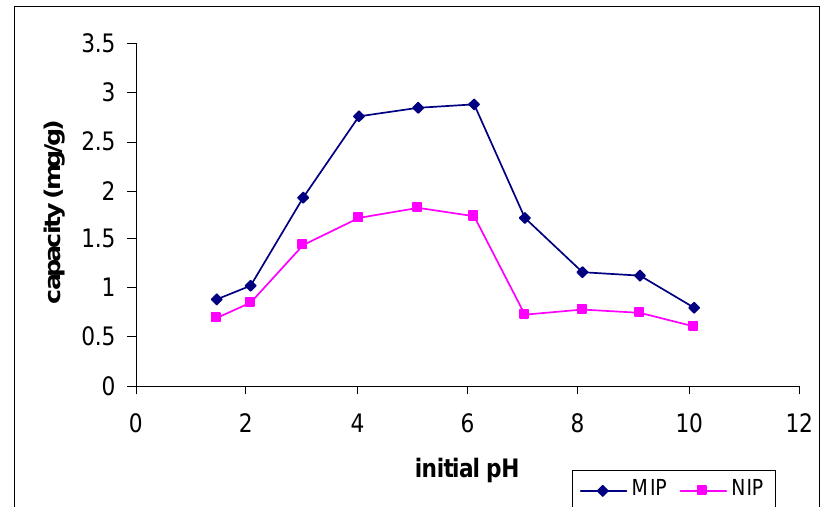
Figure 4. Effect of pH on adsorption of 2,4-dinitrophenol by MIP.